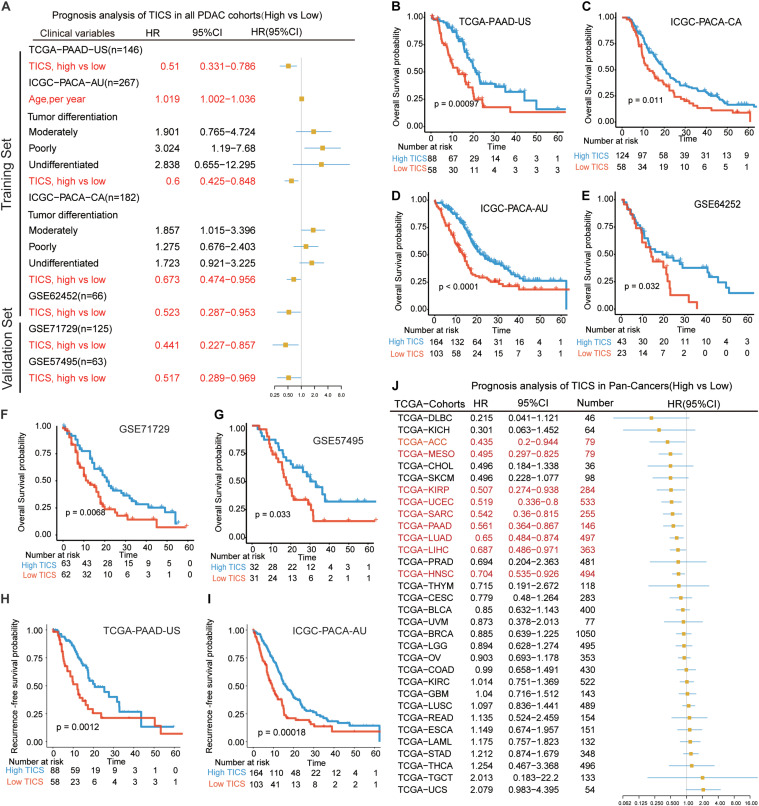
Prognostic analysis of TICS model in the training cohorts and validation cohorts. (A) Prognosis analysis of TICS in all PDAC cohorts (High vs. Low TICS). Kaplan–Meier survival curve of the overall survival (OS) in PDAC patients with high TICS and low TICS in TCGA-PAAD-US (n = 146) (B), ICGC-PACA-CA (n = 182) (C), ICGC-PACA-AU (n = 267) (D), GSE62452 (n = 66) (E), GSE71729 (n = 125) (F), and GSE57495 (n = 63) (G). Kaplan–Meier survival curve of recurrence-free survival in PDAC patients with high TICS and low TICS in TCGA-PAAD-US (n = 146) (H), and ICGC-PACA-AU (n = 267) (I). (J) Prognosis analysis of TICS in Pan-Cancers (High vs. Low TICS).